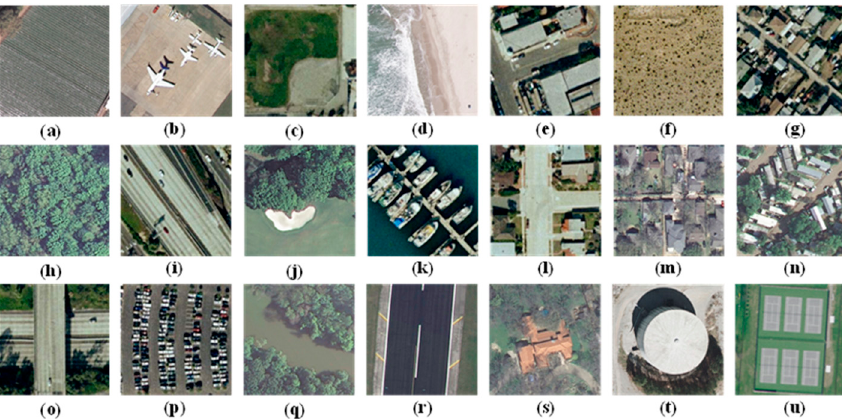
Figure 6. Class representatives of the UCM dataset: ( a ) agriculture, ( b ) airplane, ( c ) baseball diamond, ( d ) beach, ( e ) buildings, ( f ) chaparral, ( g ) dense residential, ( h ) forest, ( i ) freeway, ( j ) golf course, ( k ) harbor, ( l ) intersection, ( m ) medium residential, ( n ) mobile home park, ( o ) overpass, ( p ) parking lot, ( q ) river, ( r ) runway, ( s ) sparse residential, ( t ) storage tanks, and ( u ) tennis court.